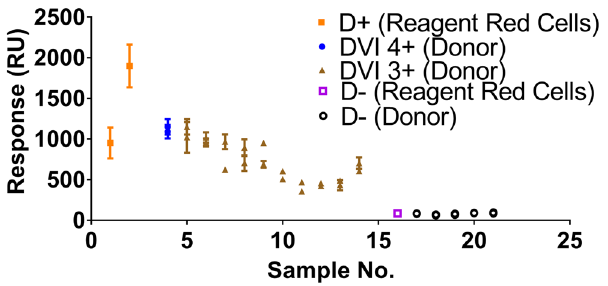
Figure 3. SPR detection of 10 partial D antigens on donor samples using anti-D IgG FFMU compared to 2 D-positive reagent cells, and 6 D-negative samples (1 reagent, 5 donor). Each sample was prepared twice, and each preparation was tested three times; the average and standard deviations are plotted. RU measured after t = 900 s when the region 4 plateaux has reached